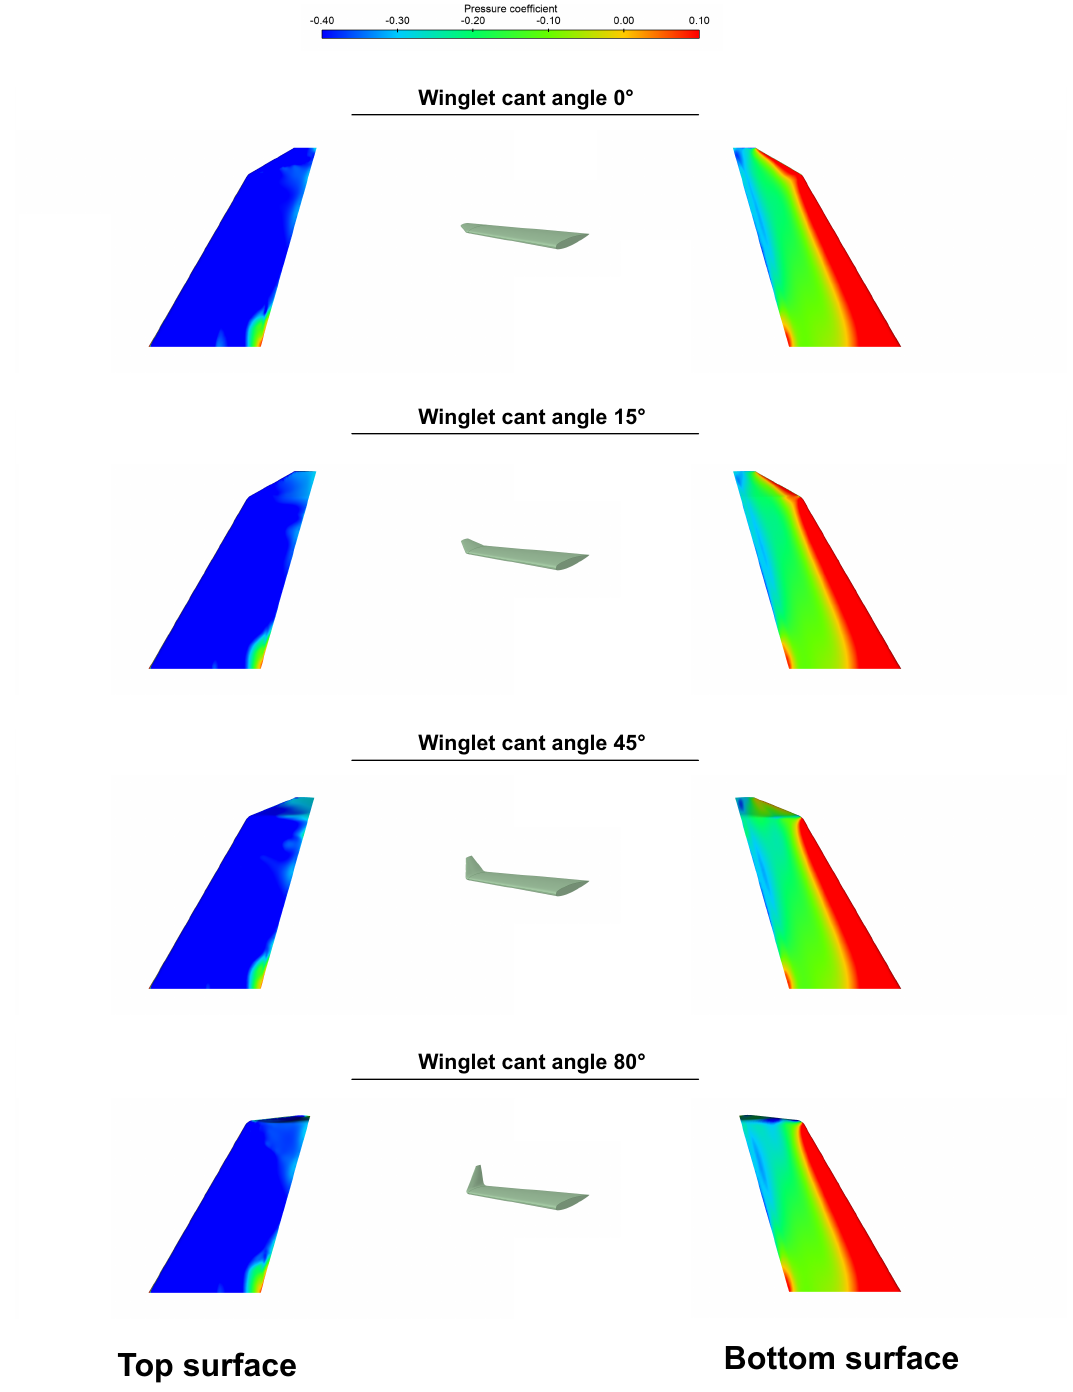
Figure 17. Pressure coefficient on the wing surface. Winglet sweep angle equal to 60 ◦ and wing AOA equal to 10 ◦